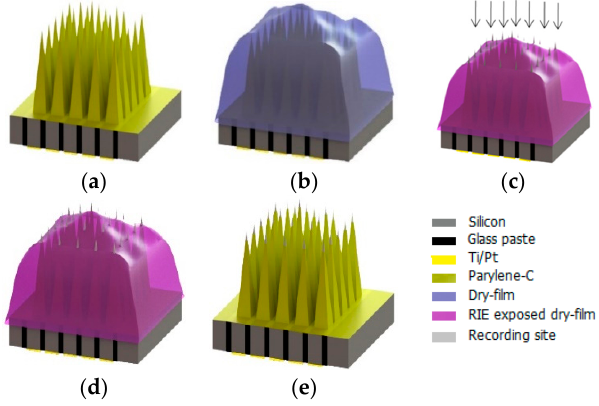
Figure 3. Process flow of Pt electrodes tip-coating: ( a ) Parylene-C deposition; ( b ) cover with dry-film photoresist; ( c ) reactive ion etching; ( d ) tip-metallization; and ( e ) lift-off in acetone.